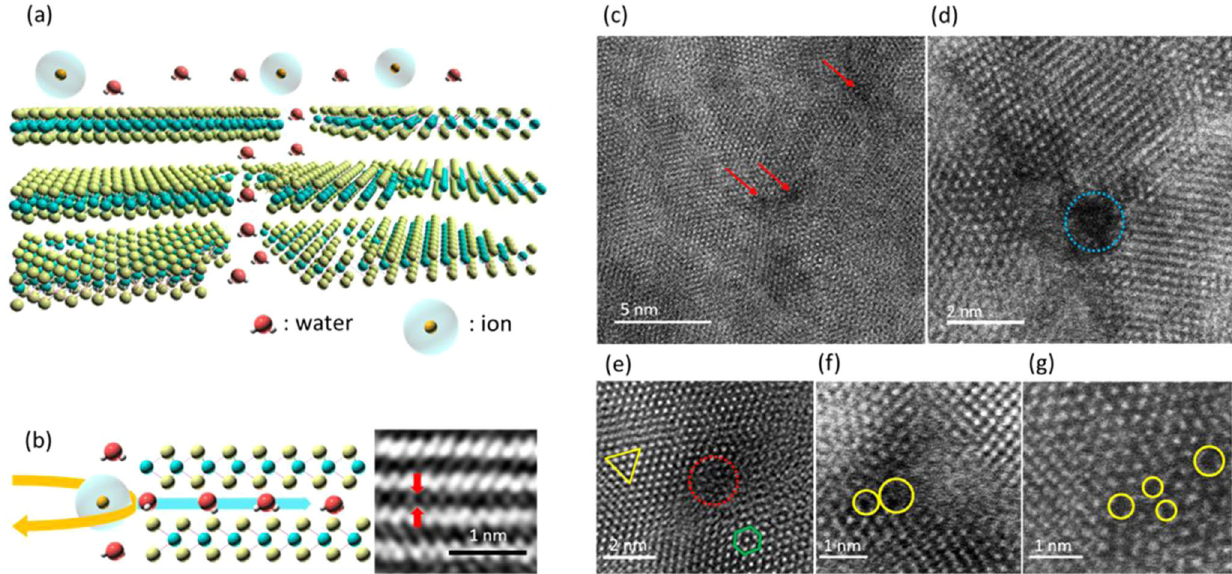
Fig. 9 The suggested desalination process explained using the inherent nanopores and vdW gaps of CVD-2D MoS 2 layers. a Water molecules translocation through nanopores ( b ) hydrated ions rejection and water molecules translocation in the interlayer spacing. c – g Shows the TEM images, con fi rming intrinsic nanopores presence within the CVD-2D MoS 2 grain boundaries revealing layers. Reproduced with permission from Nano Lett. 19, 8 (2019). Copyright 2019 American Chemical Society 118